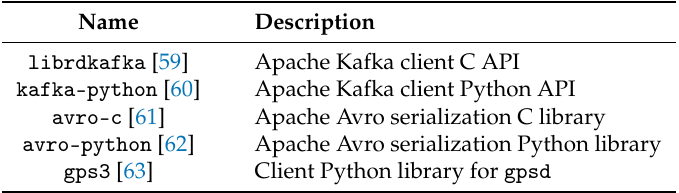
Figure 10. The Kafka cluster discussed in Section 4.3 was utilized for logging CAN, GNSS, and diagnostic data onto the SSD. The cluster communicated with a remote Kafka cluster via an encrypted tunnel for mirroring diagnostic information. Meanwhile, the RTSP video stream was saved directly to the USB HDD. Table 6. Preinstalled middlewares for the Kafka data loggers.